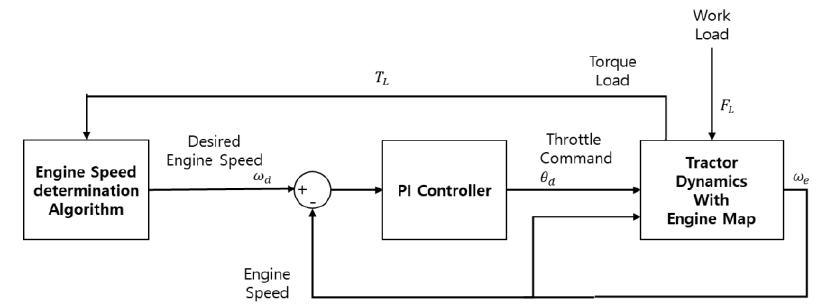
Figure 1. Block diagram of engine speed controller.